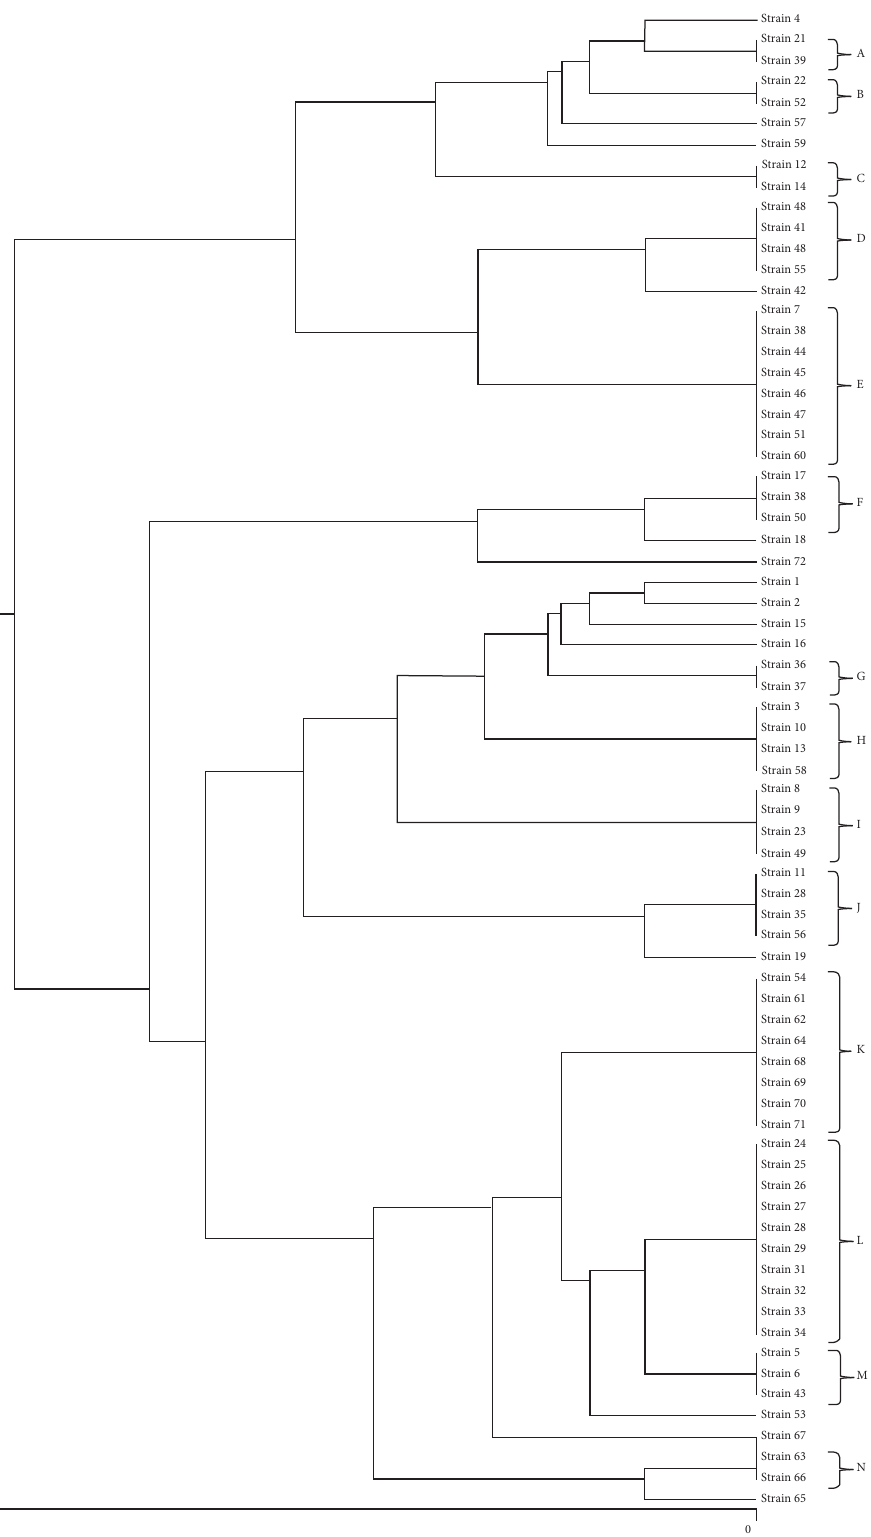
Figure 3: Dendogram of k pneumoniae isolates clustering based on ERIC